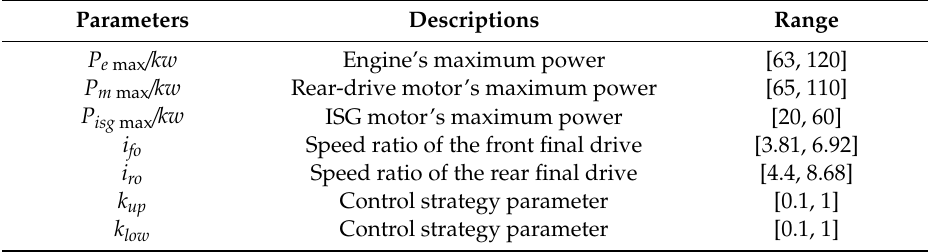
Table 2. The powertrain and control strategy’s